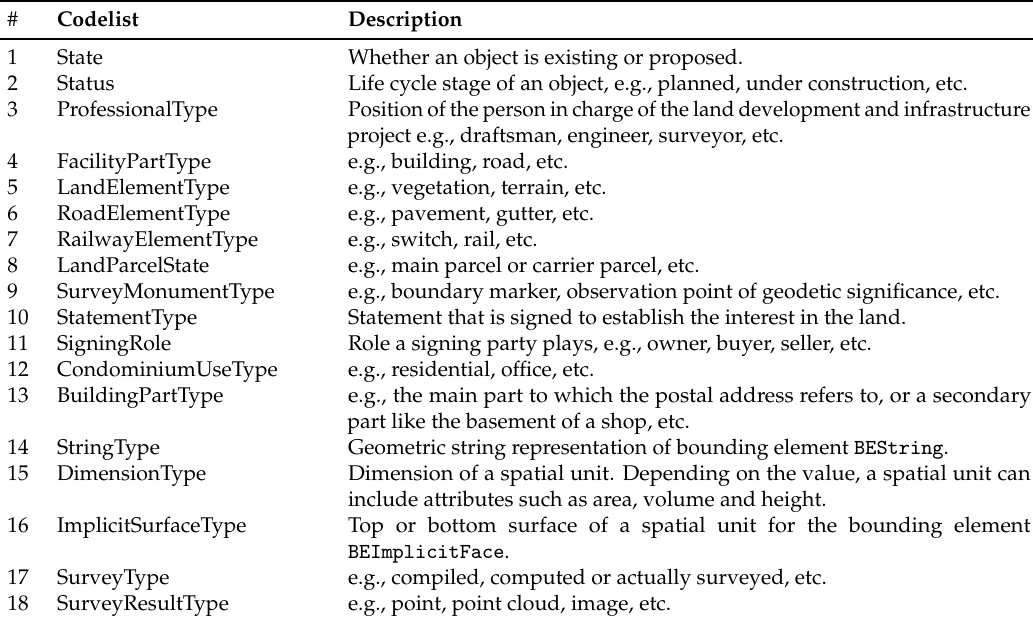
Table 3. Description of codelists included in the Infra